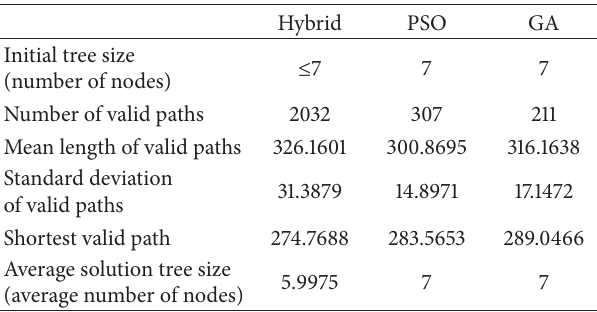
Table 4: Comparison in performance among the proposed hybrid approach, PSO, and GA for test environment II.